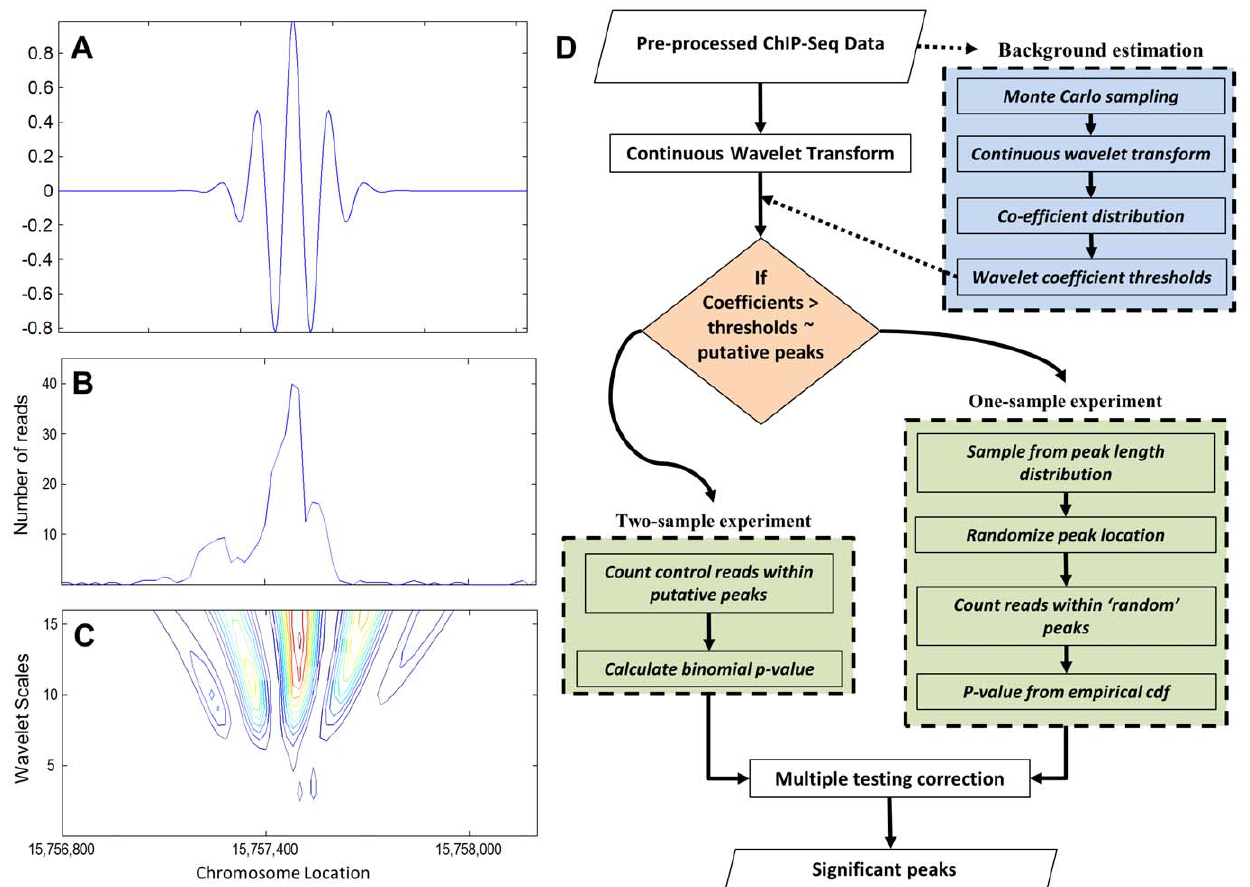
Figure 1. WaveSeq utilizes the continuous wavelet power spectrum to detect peaks in ChIP-Seq data. (a) A scaled representation of the morlet wavelet. (b & c) H3K4me3 data and a contour plot of the associated wavelet power spectrum shows hot spots that correlate with ChIP enrichments. The ChIP-Seq data represents the 15,756,800–15,758,200 bp region of the mouse chromosome 1 from the MEF H3K4me3 data set. (d) A schematic of the WaveSeq analysis pipeline. The workflow consists of two major modules: (i) the Monte Carlo background estimation step and (ii) significance estimation from randomized algorithm using the peak length distribution (one-sample experiment) or an exact binomial test (two- sample